Question: What does this figure show? Answer in one sentence.
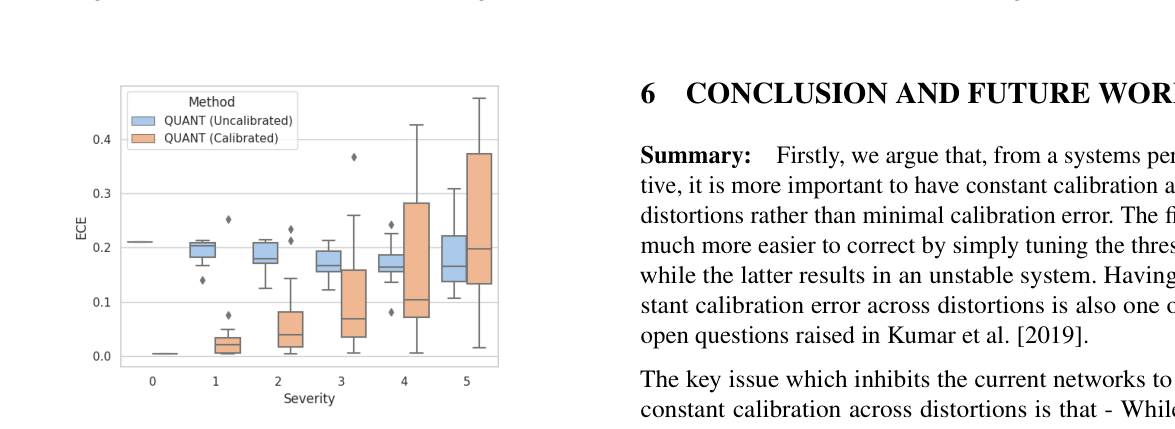
Answer: Correcting calibration error on the validation set may not improve performance on corrupted datasets.